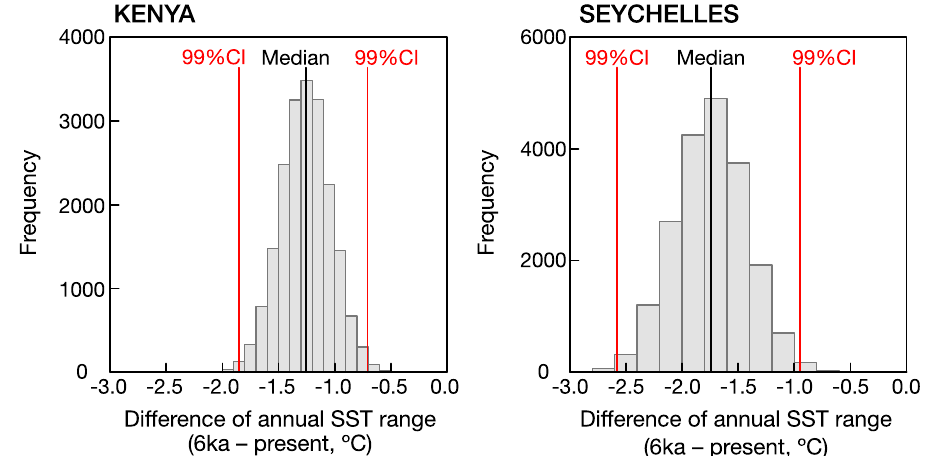
Figure 5. Reduction of SST seasonality in the mid-Holocene. Median difference (black line) with 99% confidence levels (red lines) between the mid-Holocene and modern SST seasonality estimated form Kenya (left; this study) and Seychelles corals (right, data from 17 ). At both sites, the reduction in SST seasonality is statistically significant. We used the bias-corrected and accelerated (BCa) bootstrap method in R 29 to assess the significance of our results (see “Methods” and Table S2 for details).